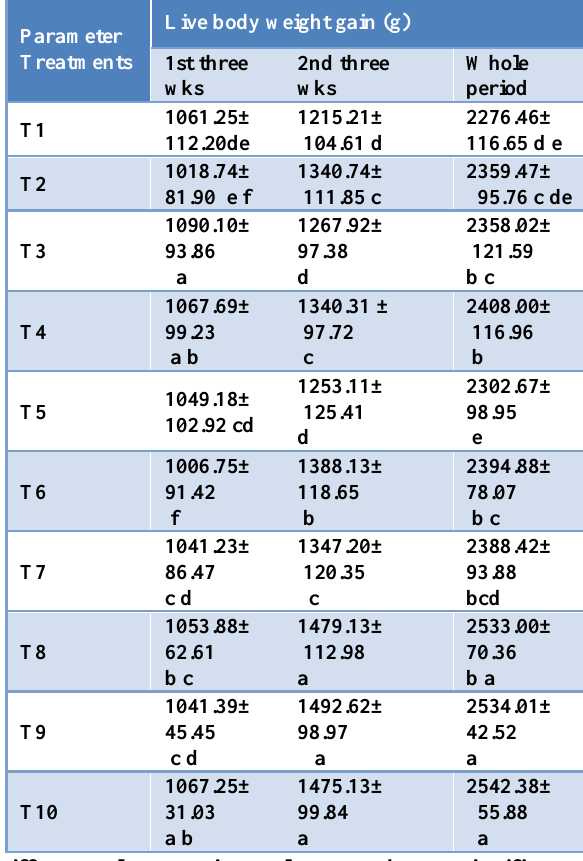
Table, 1: Effect of different levels of sweet basil powder on broiler chicks live body weight gain (g) during different three periods (M ±